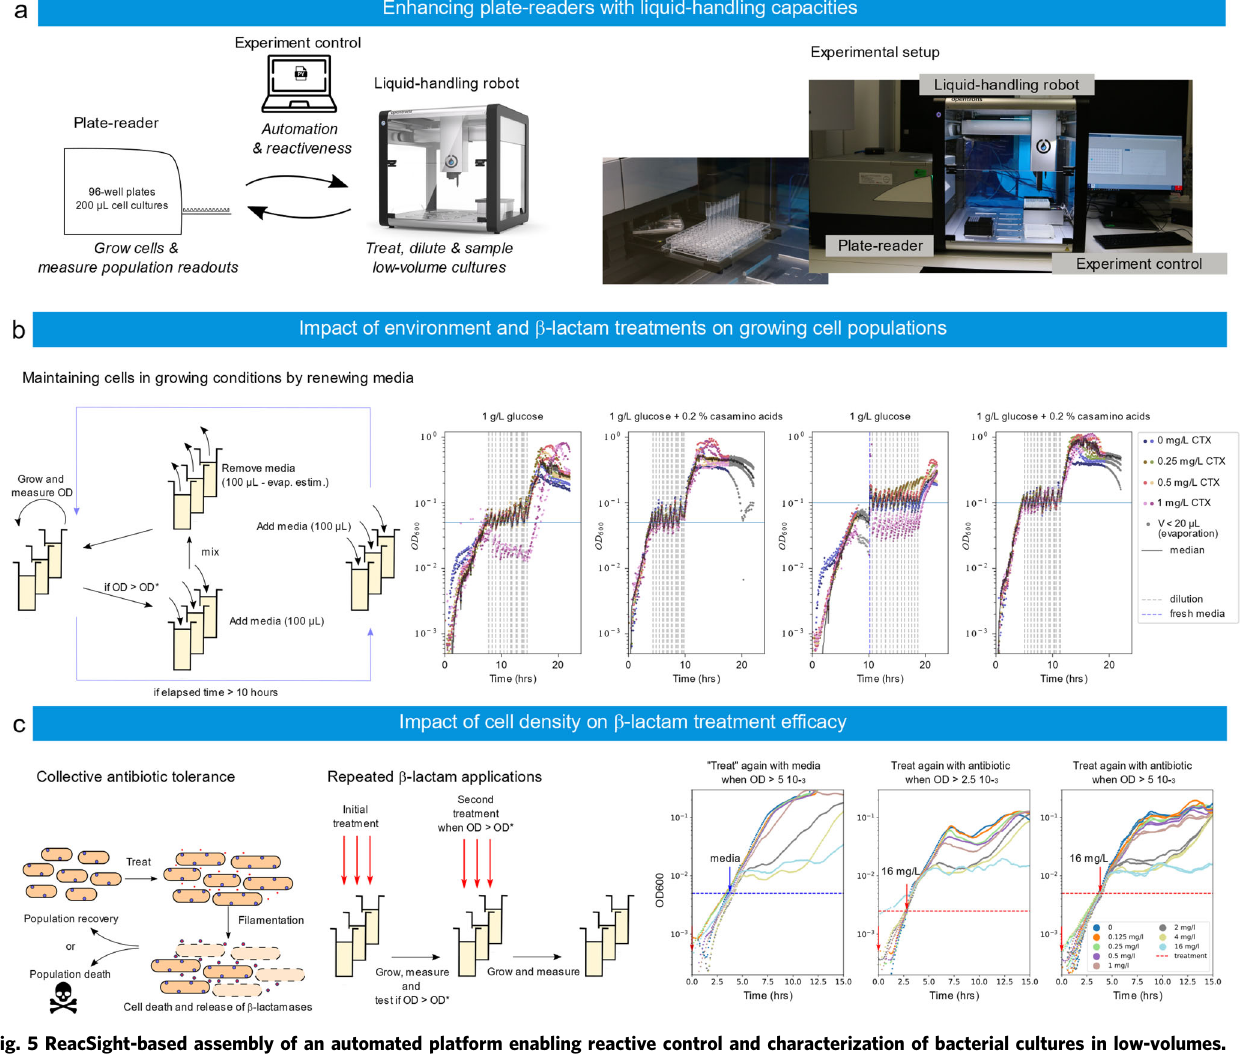
Fig. 5 ReacSight-based assembly of an automated platform enabling reactive control and characterization of bacterial cultures in low-volumes. a Platform overview. The Opentrons OT-2 pipetting robot is used to enhance the capacities of a plate-reader (Spark, Tecan). The robot is used to treat cultures in the plate-reader at prede fi ned ODs. b Left: an E. coli clinical isolate can be maintained in growing conditions by renewing the media in an OD- controlled manner. Care must be taken to compensate for evaporation over extended time scales. Right: cells in rich media (glucose + casamino acids vs glucose alone) grow faster and yet resist better sub-MIC antibiotic treatments. c Left: A bacterial population may exhibit resilience to treatments thanks to the combination of two effects. At the single-cell level, cells may tolerate an antibiotic concentration exceeding their MIC through fi lamentation. Filamentation-based tolerance allows to increase biomass before cell death. At the population level, the antibiotic is degraded by enzymes released upon cell death in the environment. The fi nal outcome depends on a race between cell death and antibiotic degradation. Middle: the respective role of these two effects can be investigated by means of repeated antibiotic treatments. Right: an E. coli clinical isolate is treated with different concentrations of CTX (legend) at an initial of OD of 5 10 − 4 , and a second time with either 16 mg/L of CTX (red) or media alone (blue) at a user-de fi ned OD (2.5 10 − 3 or 5 10 − 3 ). Because of instrument limitations, OD readouts below 10 − 3 are poorly reliable. Source data are provided as a Source Data fi